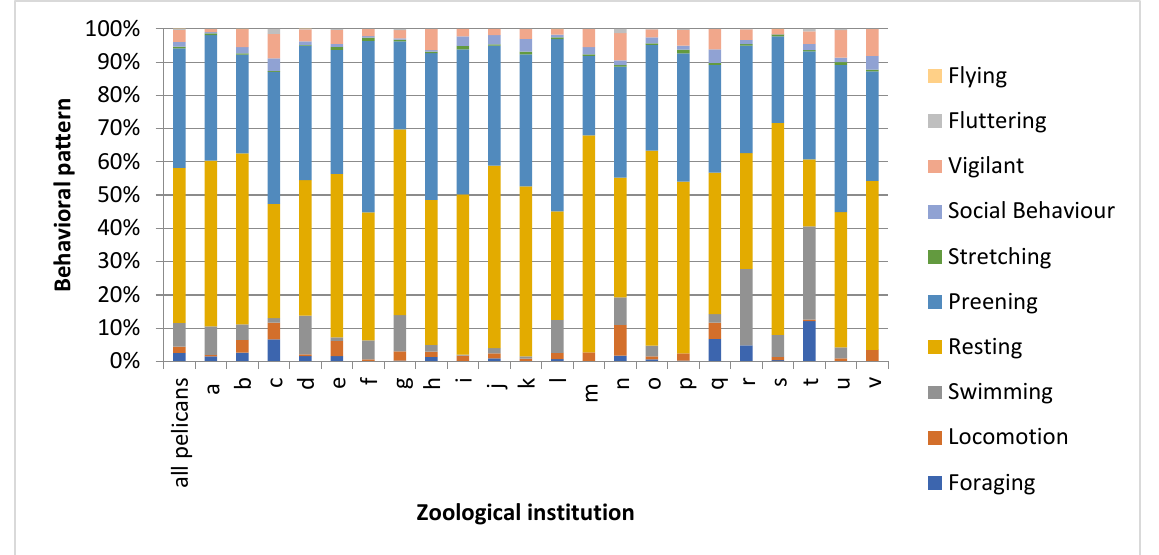
Figure 2. Activity of pelicans kept in 22 German zoos: the percentages of time that the animals spent on each behavior. In zoos keeping airworthy pelicans, the proportion of flying was